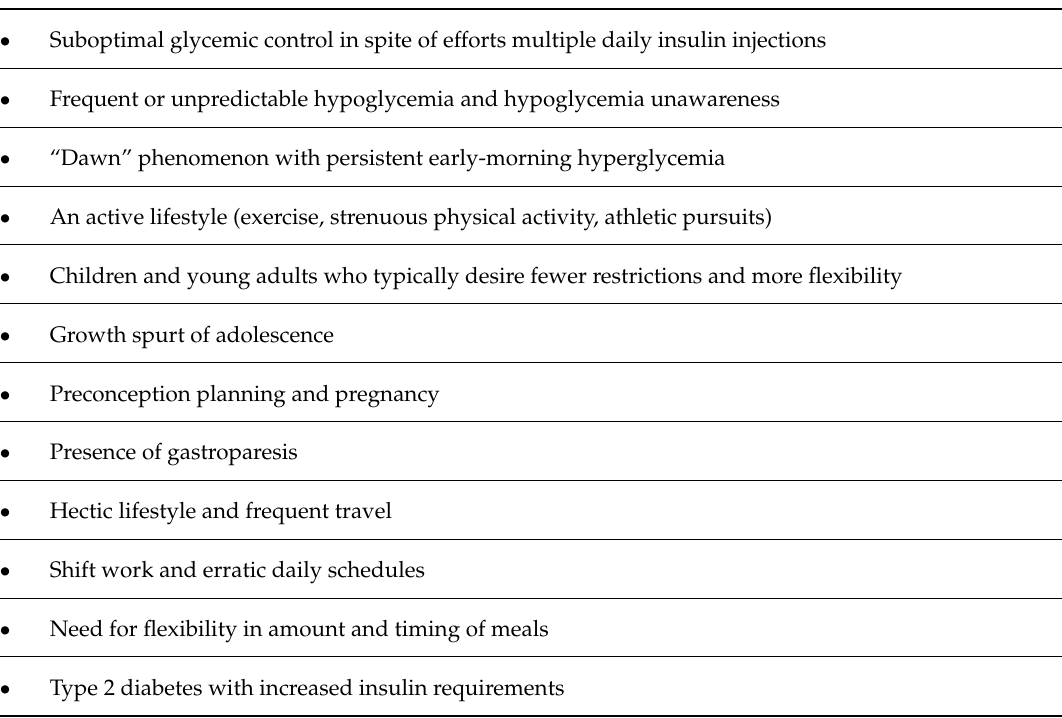
Table 2. Indications for Insulin Pump